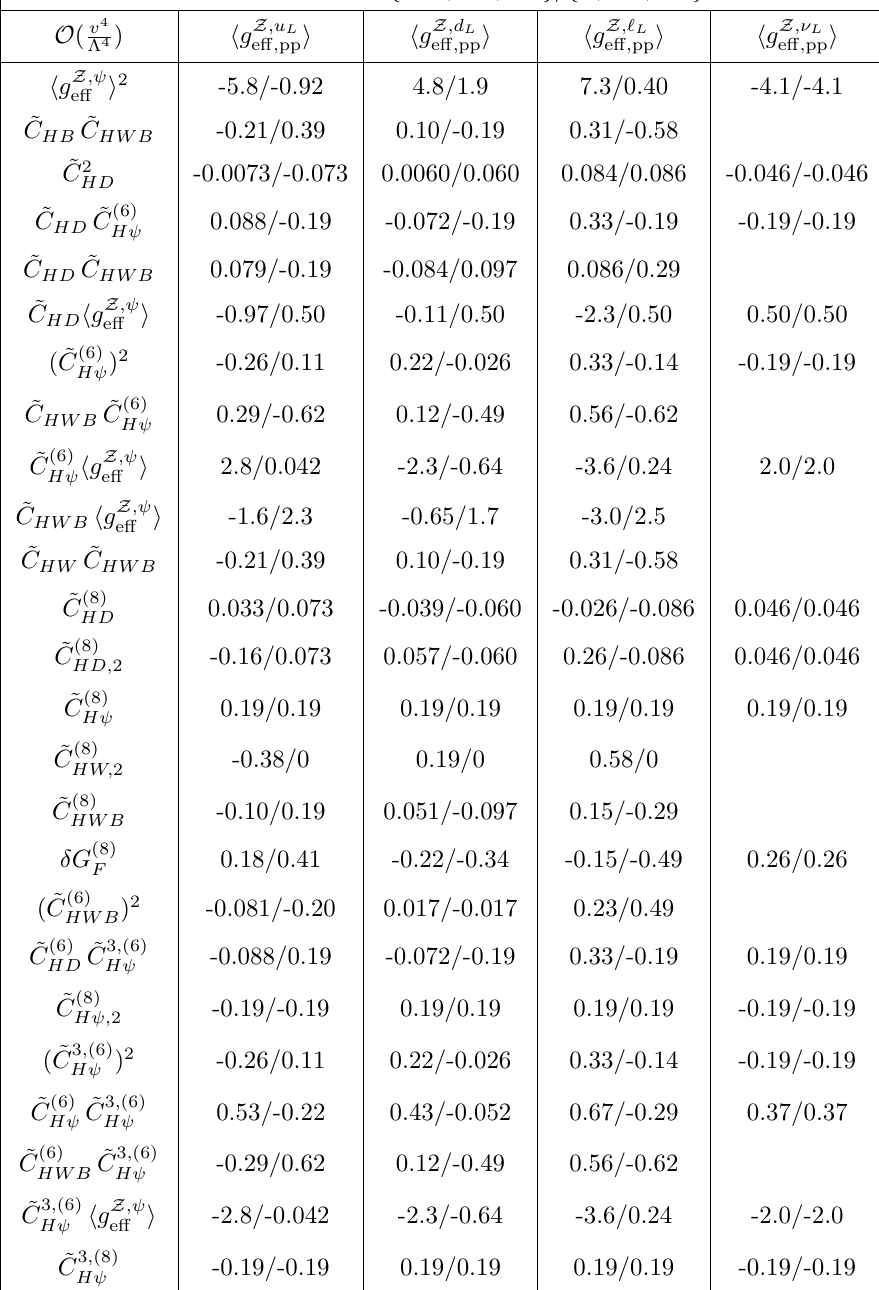
Table 7 . The effective couplings expanded to O ( v 4 / Λ 4 ) in each input parameter scheme. δG (8) and the remaining operator forms are defined in refs. [15,